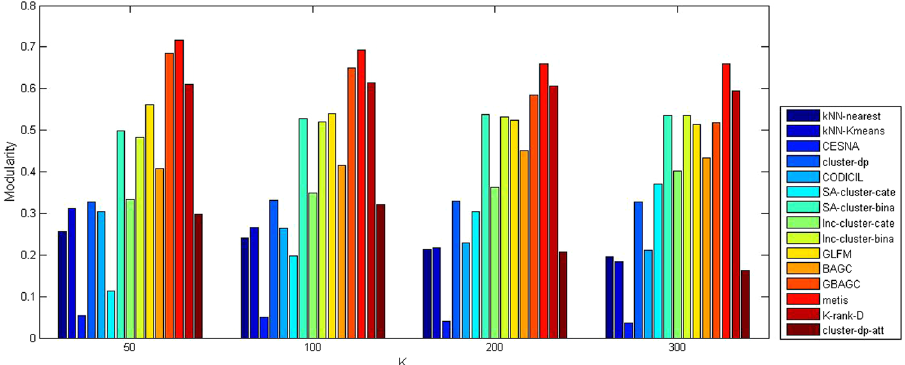
Figure 3. Modularity of the compared algorithms on DBLP10k.